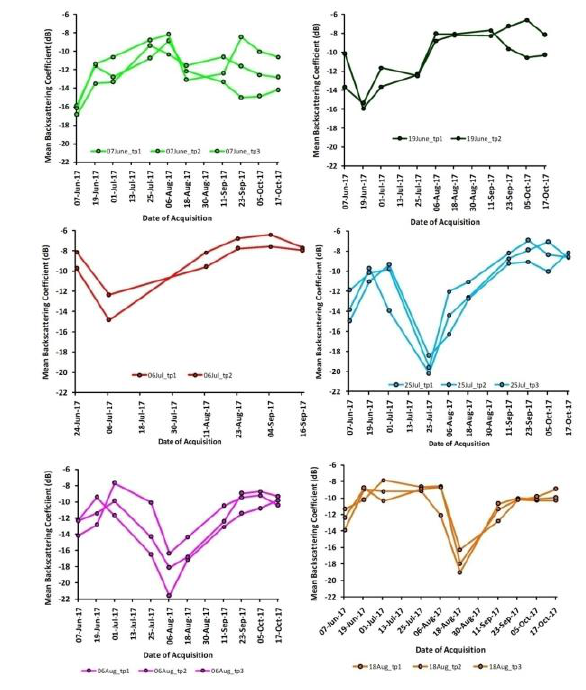
Figure 2. Temporal Backscatter profiles of rice crop in Bhadrak district, Odisha.